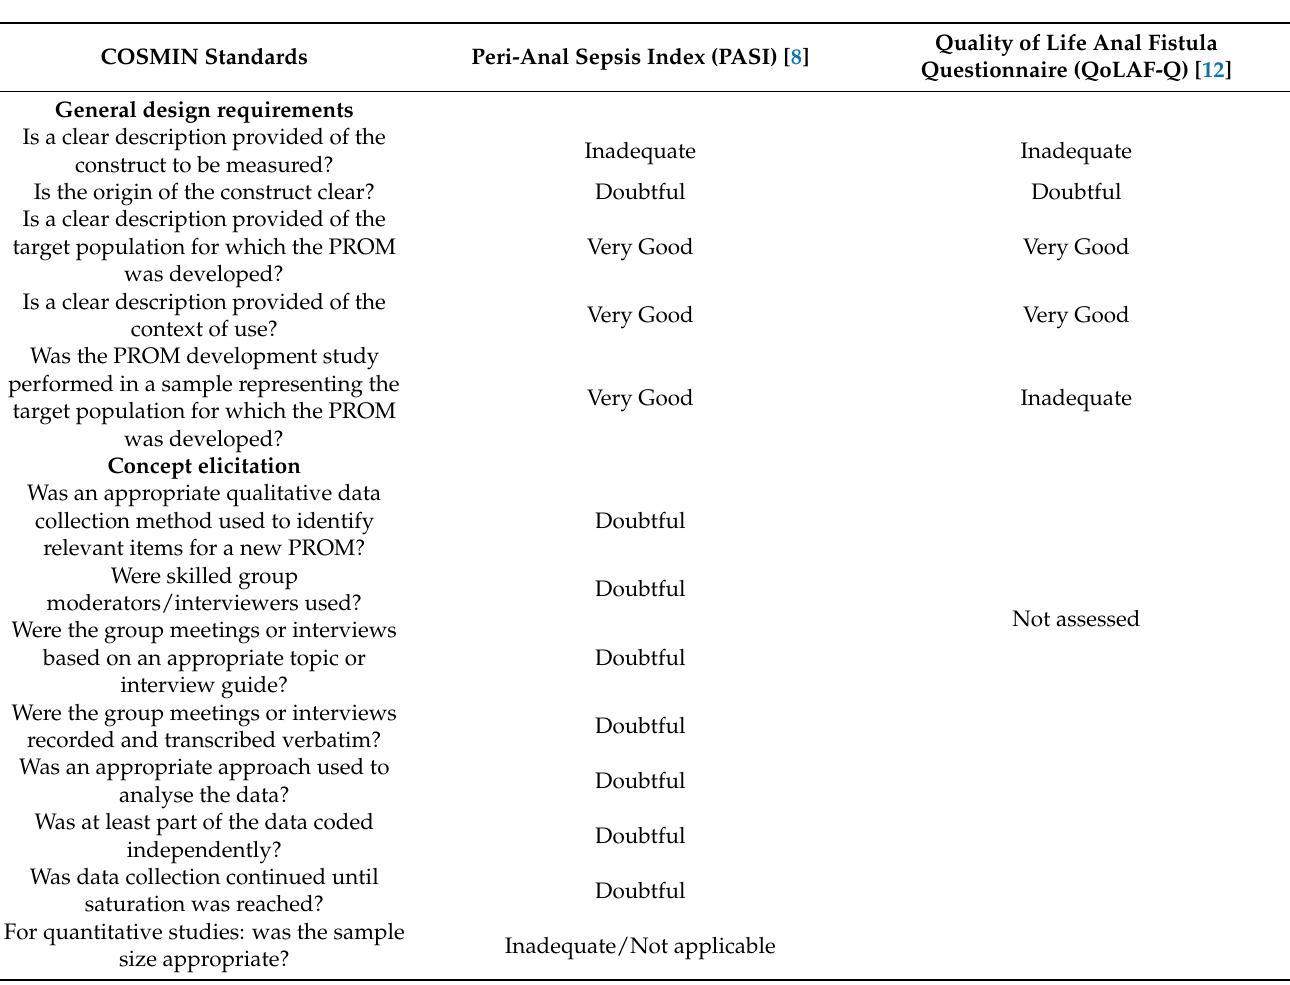
Table 1. Evaluation of PROM design according to COSMIN criteria for PROM development studies (COSMIN box